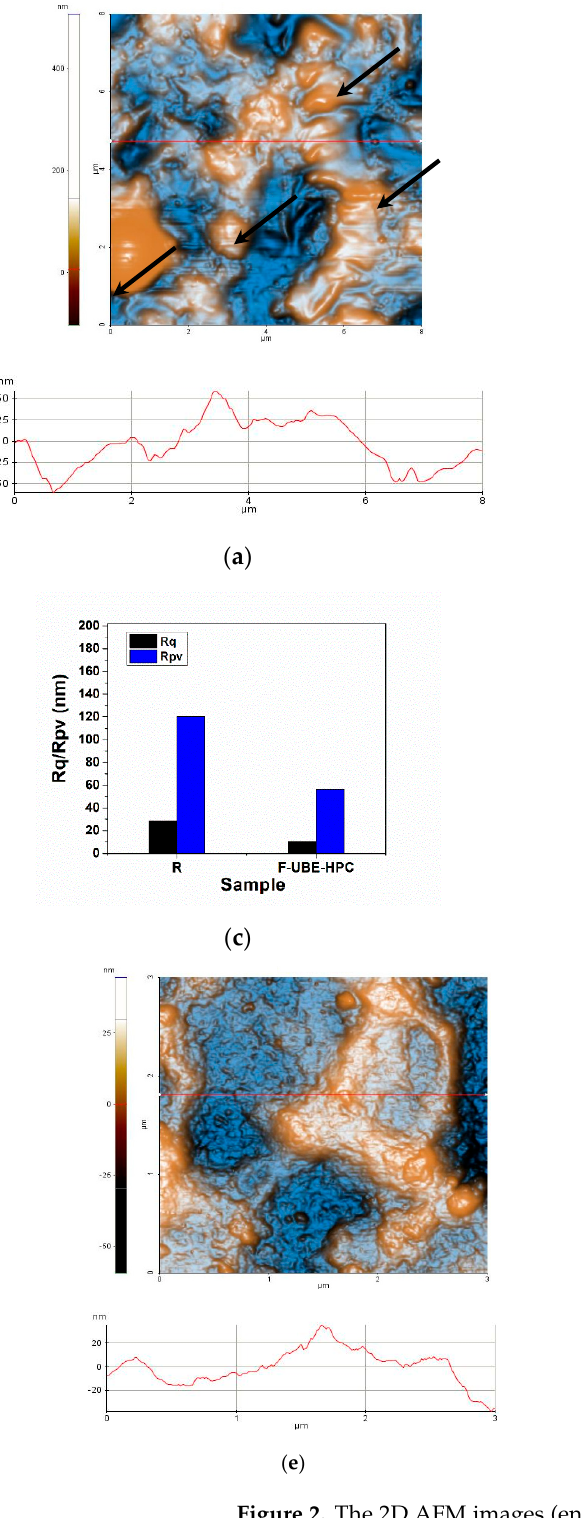
representative line-scans for bioadhesive films: ( a ) R, ( b ) F-UBE-HPC; roughness (Rq) and peak-to- valley (Rpv) parameters ( c ) along the line scans and ( d ) for the whole scanned areas; 2D AFM images